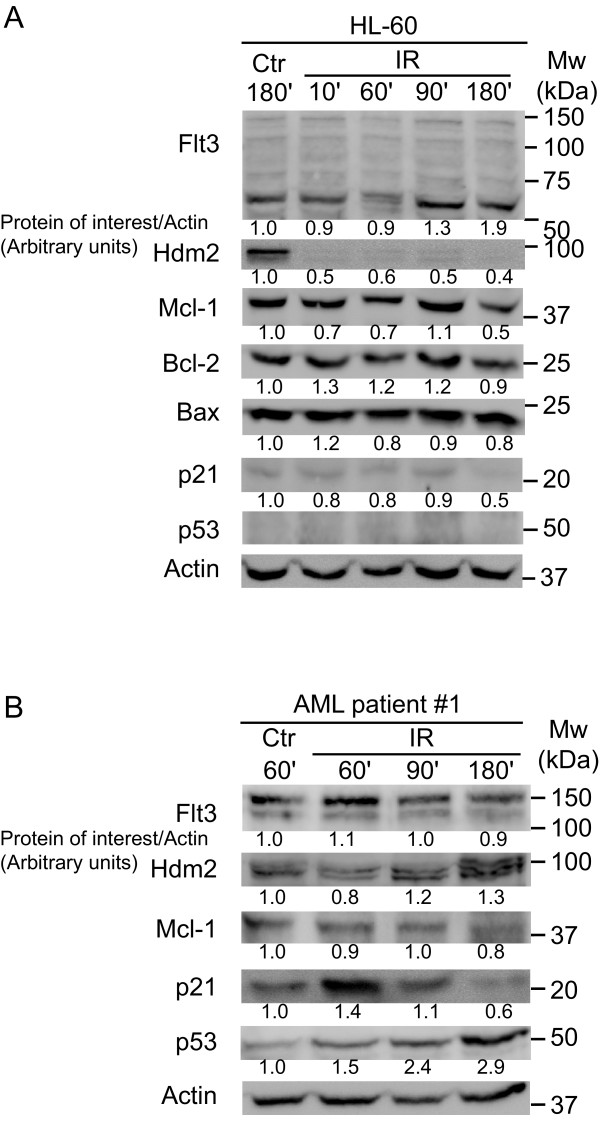
IR decrease Hdm2 protein in HL-60 (p53 -/-) and in primary AML cells. A. HL-60 cells treated with 25 Gy and harvested at indicated time (minutes) demonstrated a rapid decrease in Hdm2 protein after IR. There was no detectable Flt3 protein at 130 kDa. B. Primary AML cells also treated with IR and harvested at indicated time, demonstrated the rapid Flt3 increase and Hdm2 attenuation as previously observed. This was followed by an increase in Hdm2, reflecting functional and elevated p53 protein. Mean intensity on the Western blots were measured and normalized to Actin and to the control. Values shown are arbitrary units and represent one typical experiment.